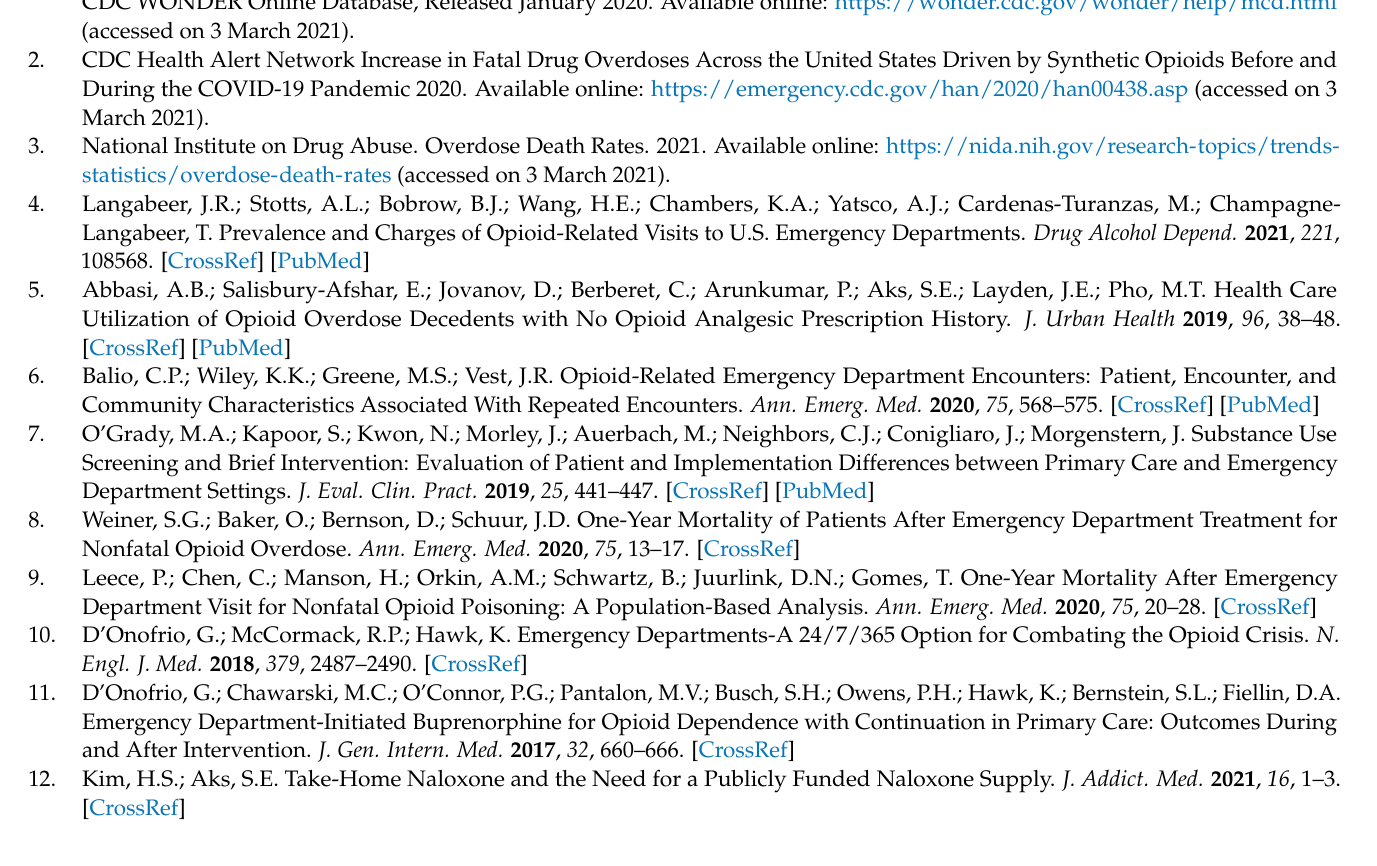
Table S2: ICD-10 codes; Table S3: STROBE Statement—checklist; Table S4: Patient characteristics odds ratios by latent